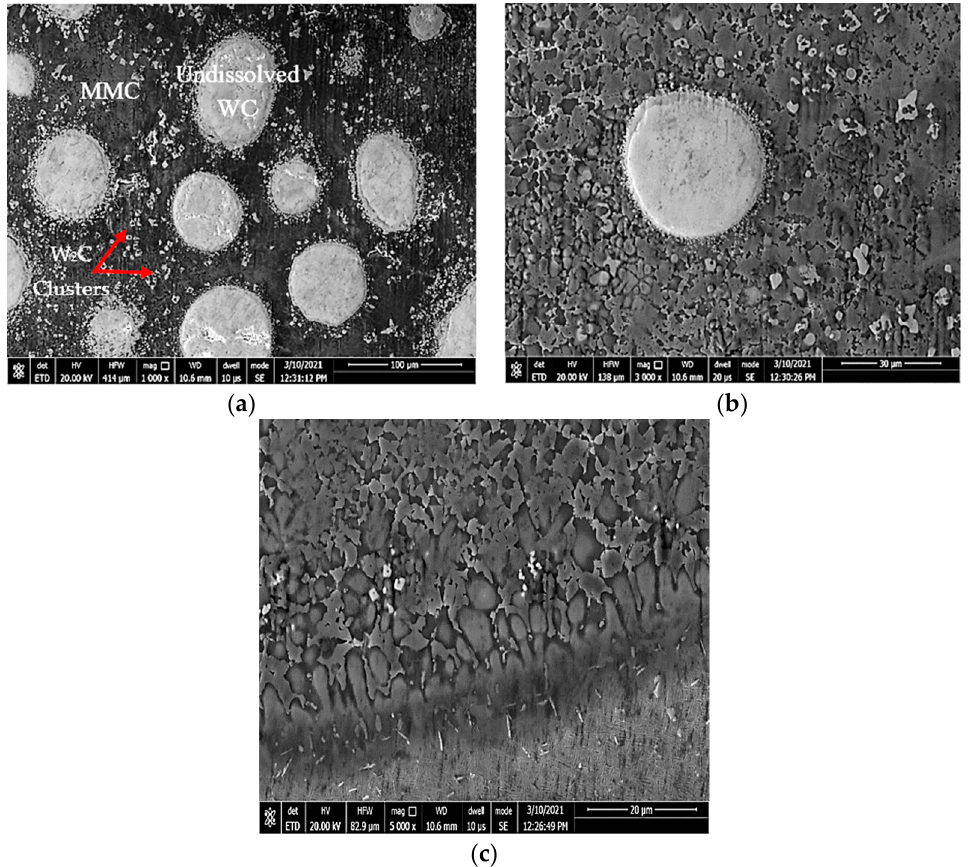
Figure 15. FESEM micrographs of the ( a ) hypereutectic structure at the DZ, ( b ) dendritic structure at the IZ, and ( c ) large dendrite structure close to the fusion line.